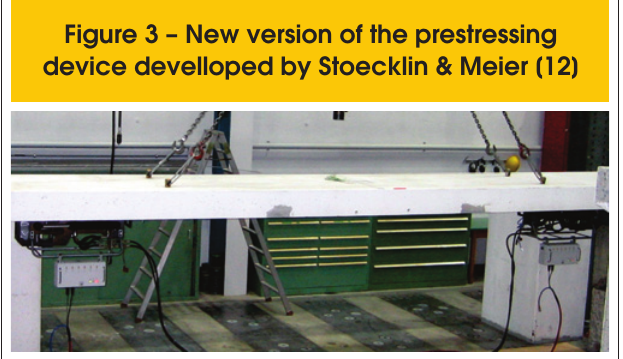
Figure 3 – New version of the prestressing device develloped by Stoecklin & Meier [12]